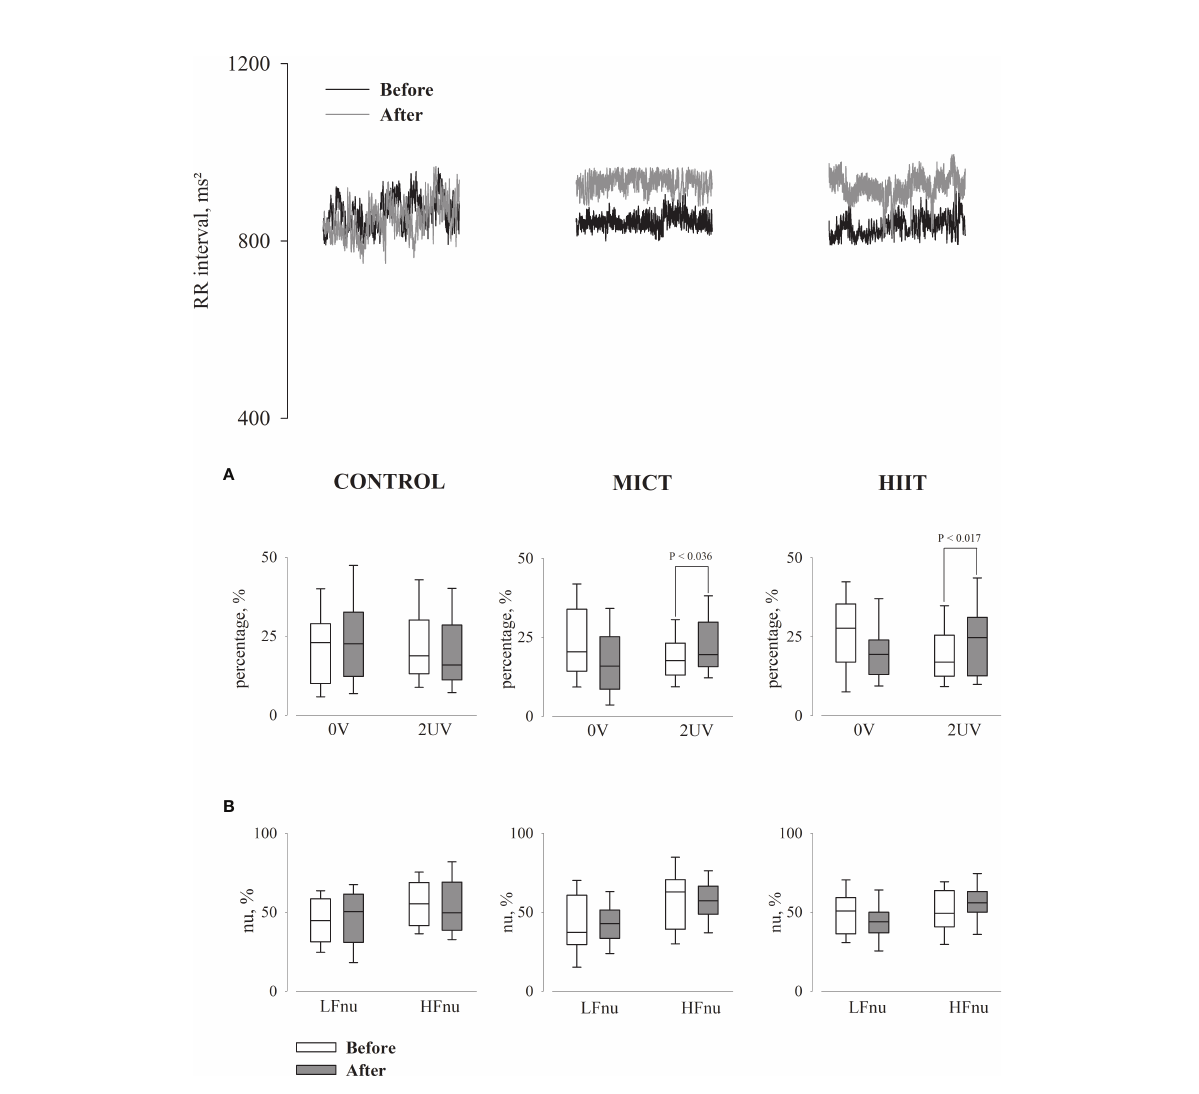
FIGURE 2 Cardiac interval segments obtained during rest in supine position for all groups, before and after 16 weeks of the intervention. (A) Graphs showing the symbolic analysis; 0V, patterns with no variation (sympathetic modulation); 2UV, patterns with two unlike variation (vagal modulation). (B) Graphs showing the spectral analysis in normalized units (nu); LF, low frequency band (sympathetic modulation); HF, high frequency band (vagal